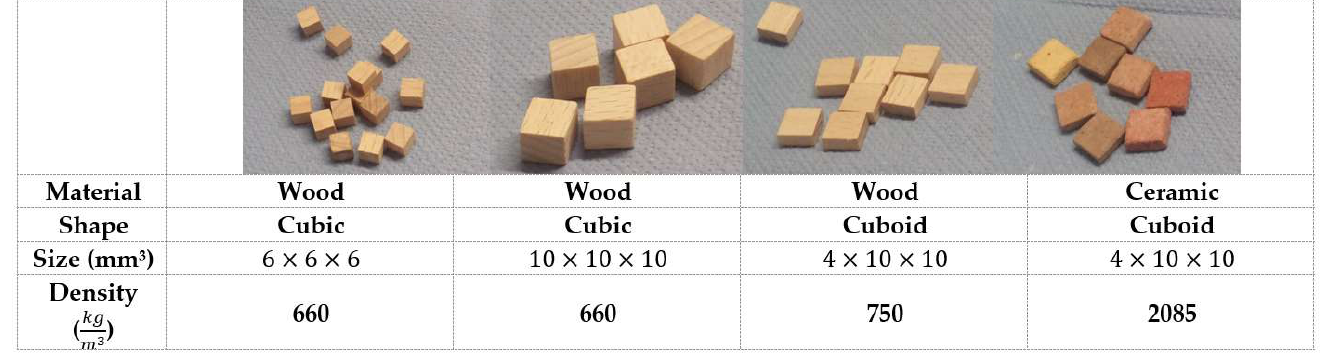
Figure 1. Particle shapes and their properties.